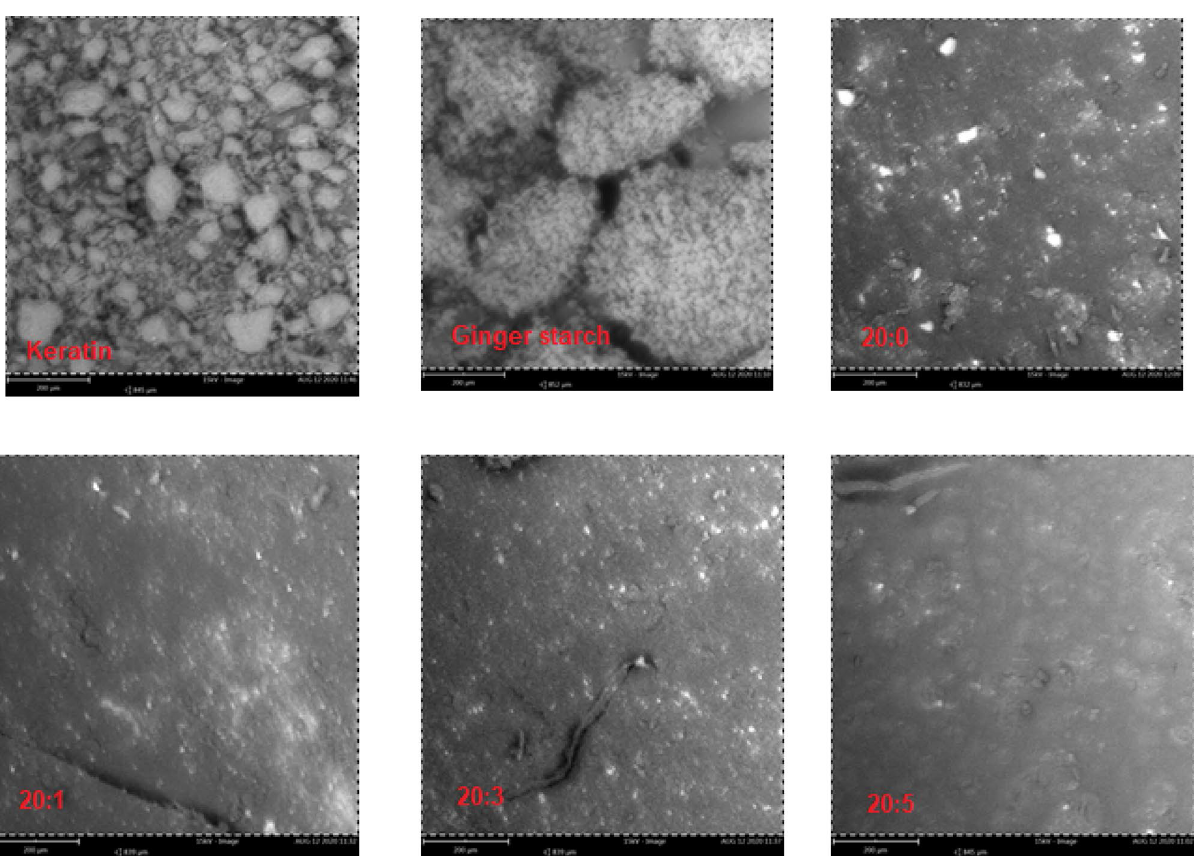
Figure 6. SEM images of keratin, ginger starch, and bio-composite films made of difference blends of starch and keratin solutions. Note: 20:0, 20:1, 20:3, and 20:5 = starch/keratin ( v / v